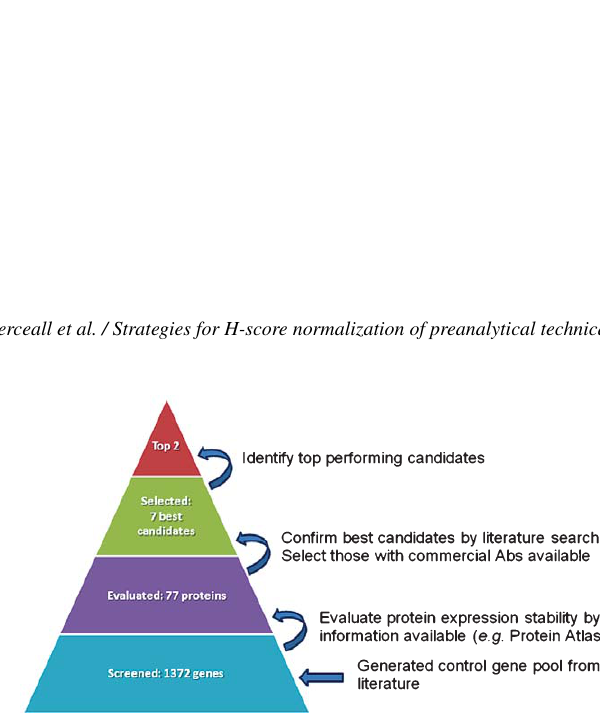
Fig. 1. Flowchart for identification of best candidate calibrator biomarkers. The schema by which candidate calibrators were identified and vetted is depicted. From a pool of over 1300 candidate genes, literature searches and survey of open access sources such as Protein Atlas and GeneCards stratified the search to an assessable number for laboratory investigation and characterization.